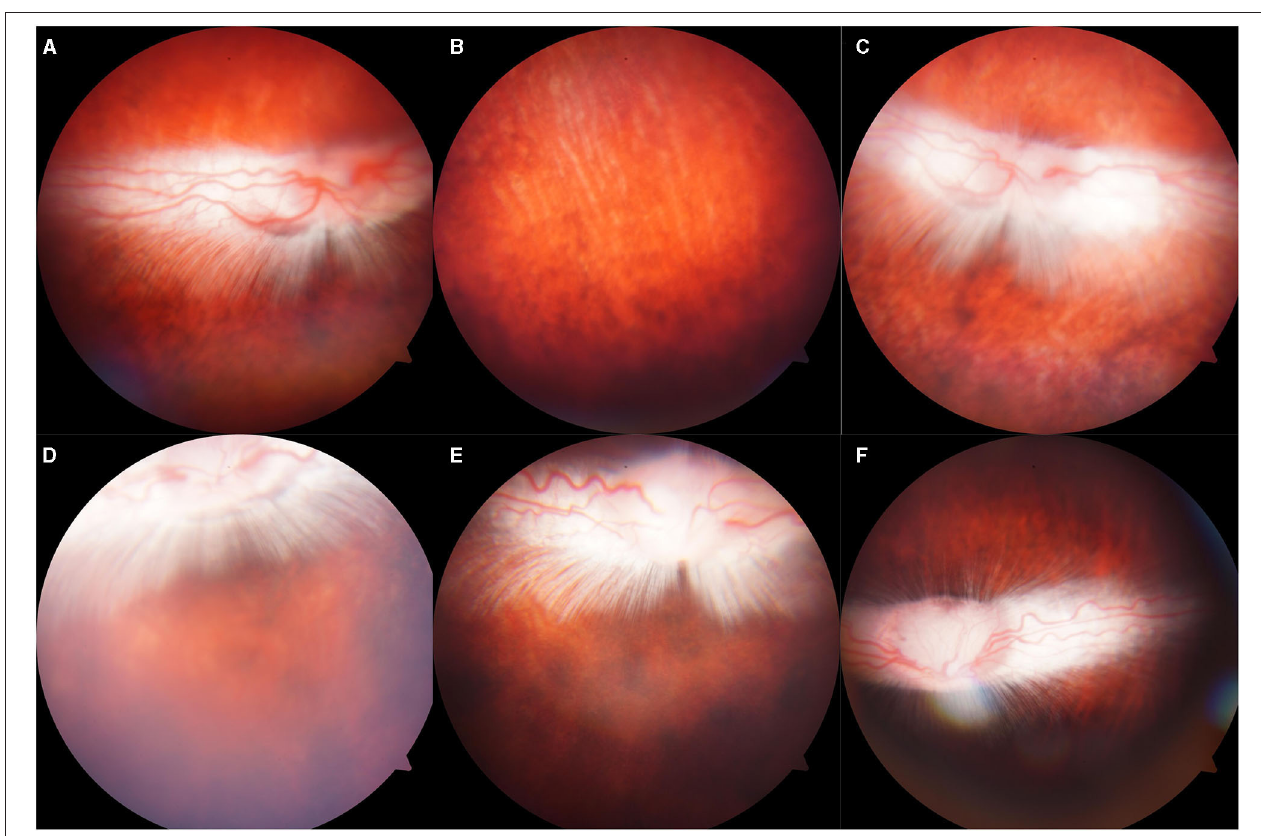
FIGURE 4 | Representative fundus photographs obtained from the eyes of the rabbits. (A,B) : Normal group: Retina was well-attached with clear vessels. (C–F) : Eyes exposed to 500, 1,000, 1,500, 2,000: Retina was attached, no retinal bleeding or vitreous hemorrhage was detected.